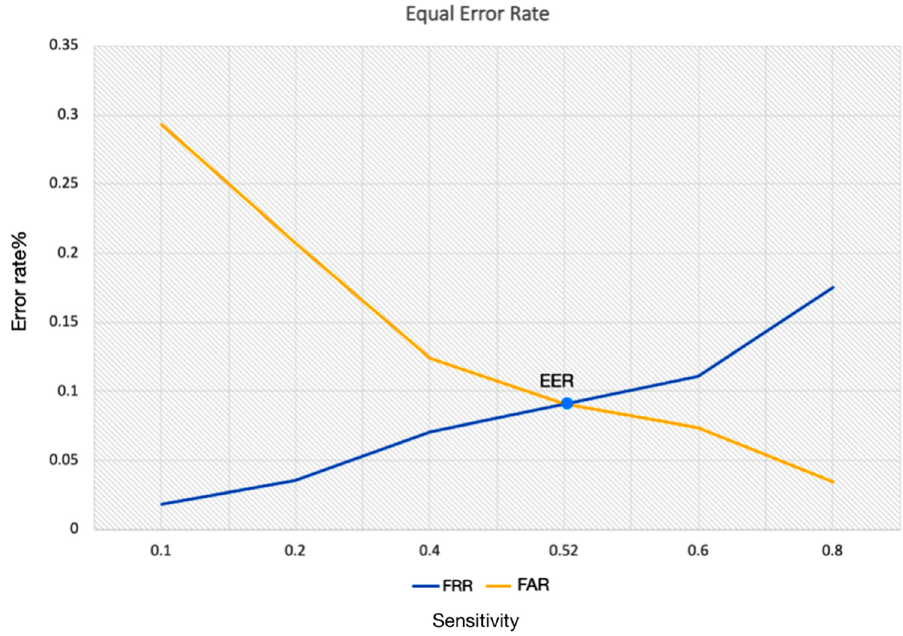
Figure 9. Equal error rate (EER). FAR: false positive rate; FRR: false negative rate.